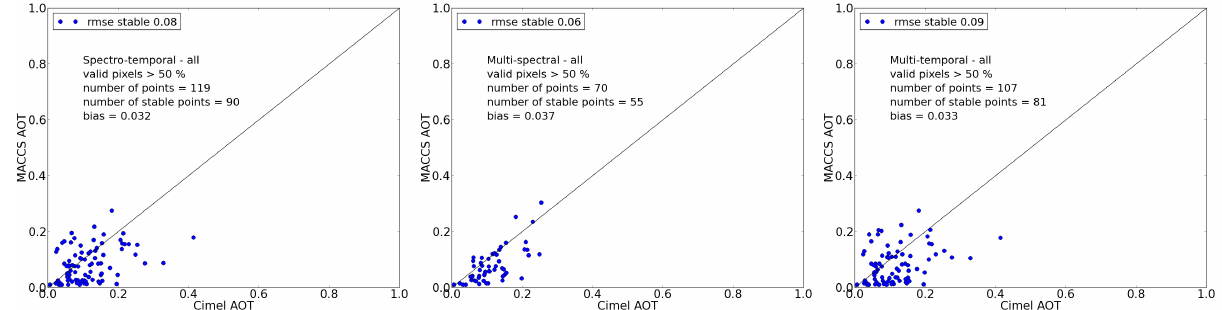
Figure 12. Comparison of AOT estimates from LandSat 5 and 7 at 550 nm obtained for all sites from the hybrid method (left), the multi-spectral method (middle) and the multi-temporal method (right), in stable